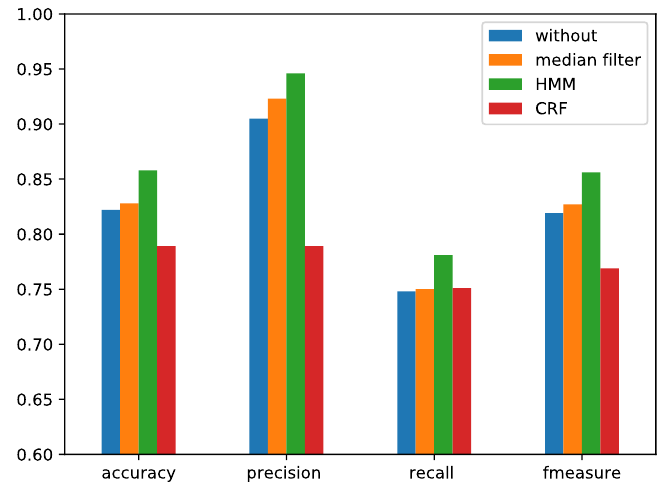
Figure 19. The comparison of different temporal smoothing methods as post-processing on the Jamendo